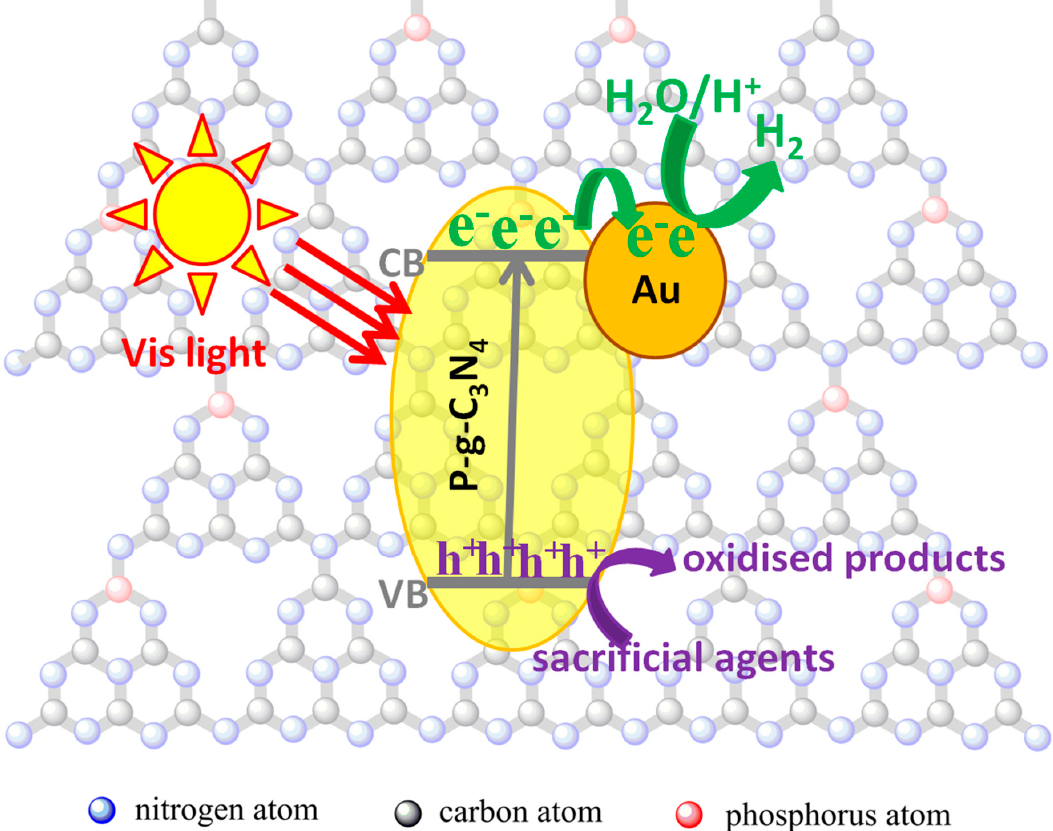
Figure 8. The mechanical illustration of enhanced photocatalytic activity for 3% Au/P-g-C 3 N 4 sample.